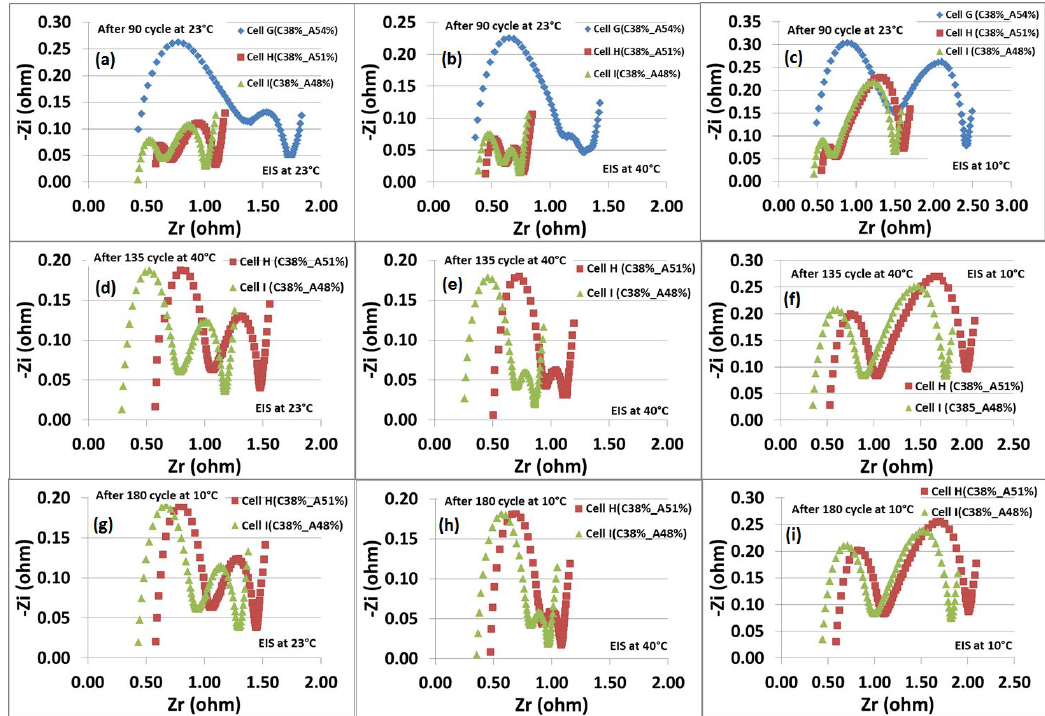
Figure 5. Impedance spectra of Li-ion full cells containing electrodes with different porosities: ( a – c ) electrochemical impedance spectroscopy (EIS) measurement at 23 ◦ C, 40 ◦ C and 10 ◦ C after 90 cycles cycled at 23 ◦ C, respectively; ( d – f ) EIS measurement at 23 ◦ C, 40 ◦ C and 10 ◦ C after 135 cycles cycled at 40 ◦ C, respectively; ( g – i ) EIS measurement at 23 ◦ C, 40 ◦ C and 10 ◦ C after 180 cycles cycled at 10 ◦ C,